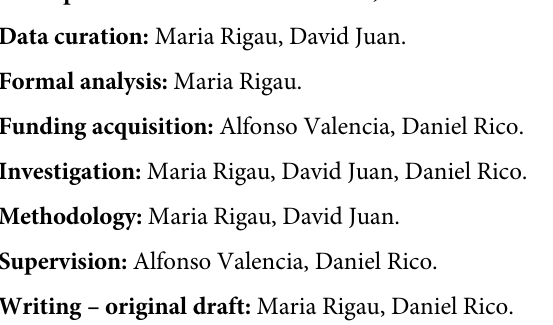
S3 Table. Top genes with more or less deletions than expected. S4 Table. List of differentially expressed genes (eGenes). S5 Table. Summary of differentially expressed transcripts (eTranscripts). S6 Table. Overlap of intronic deletions with regulatory features. S7 Table. List of CNVs and their impact on genes. S8 Table. Genes affected by deletions in any CNV